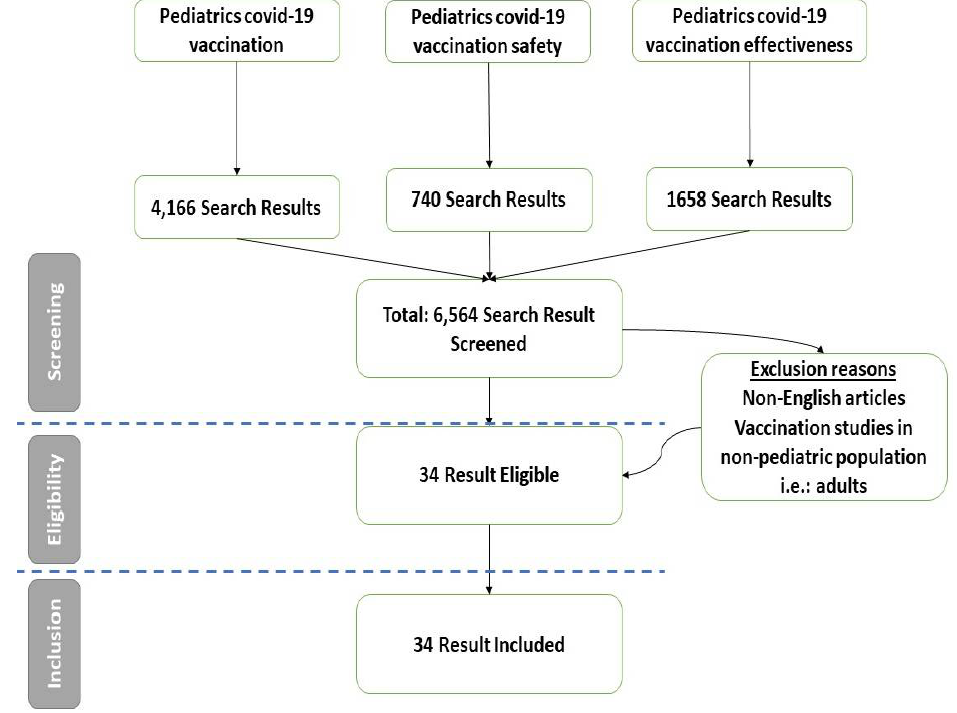
Figure 1. Flowchart of the article selection process.